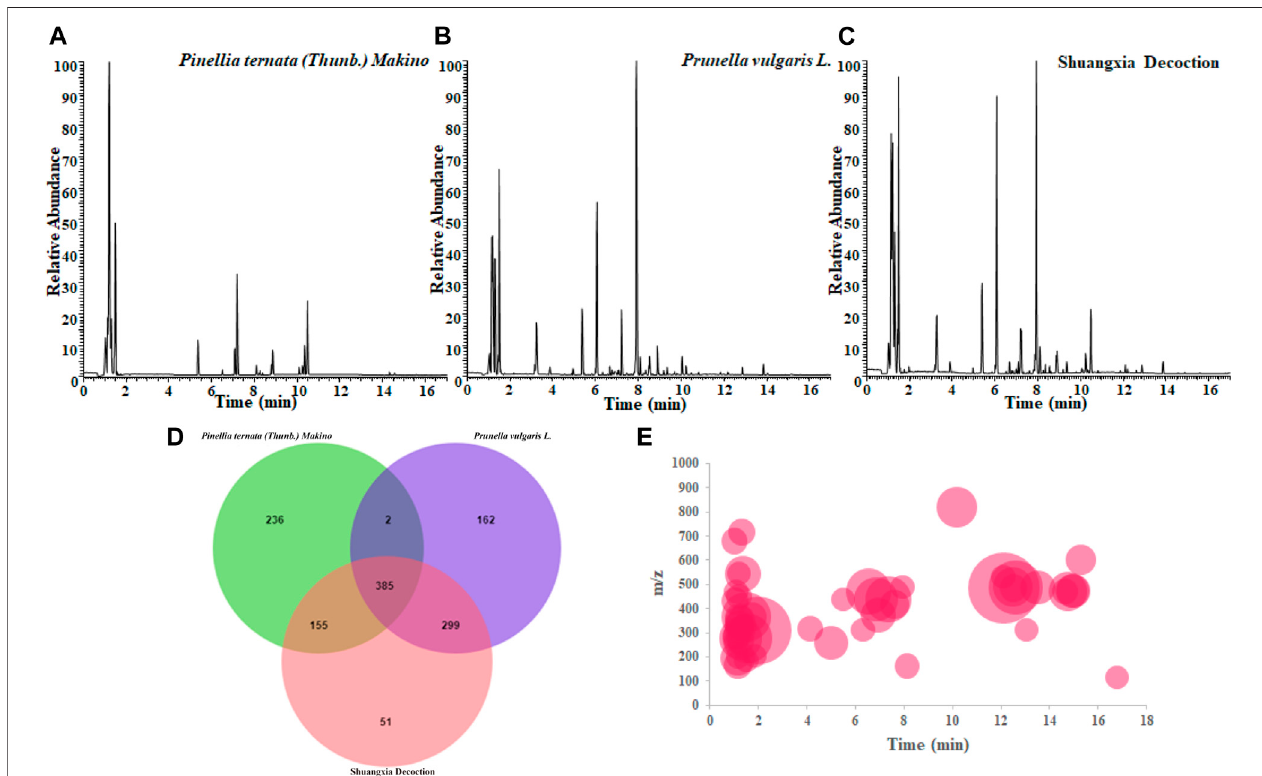
FIGURE1| BPIchromatogram of Pinelliaternata (Thunb.) Makino (A) and Prunellavulgaris L. (B) individualdecoctionand theco-decoction(Shuangxiadecoction) (C) ; the main common compounds and unique compounds of the three decoction liquids were analyzed via jvenn website (D) ; distribution trend of MS information of newgeneratedcompoundsafterco-decoction (E) .Thechromatographicretentiontimeandm/zvalueofeachnewcompoundarepresentedonthecoordinateaxis,and the relative normalized value is expressed by the size of the